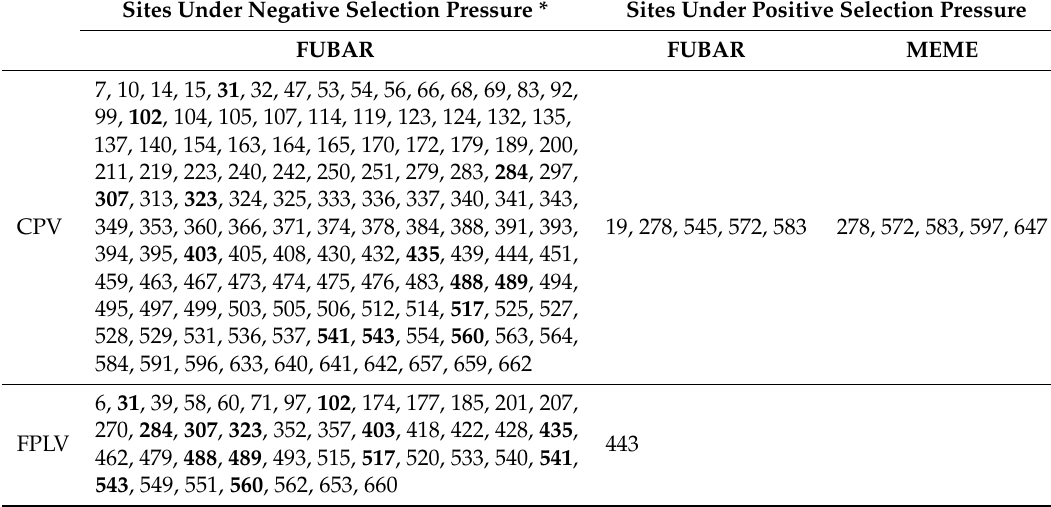
Table 5. List of codons within NS1 gene sequence identified as being under negative or positive selection pressure. FUBAR—Fast Unconstrained Bayesian Approximation for inferring selection; MEME—Mixed-E ff ects Model of Evolution. Sites Under Negative Selection Pressure * Sites Under Positive Selection Pressure